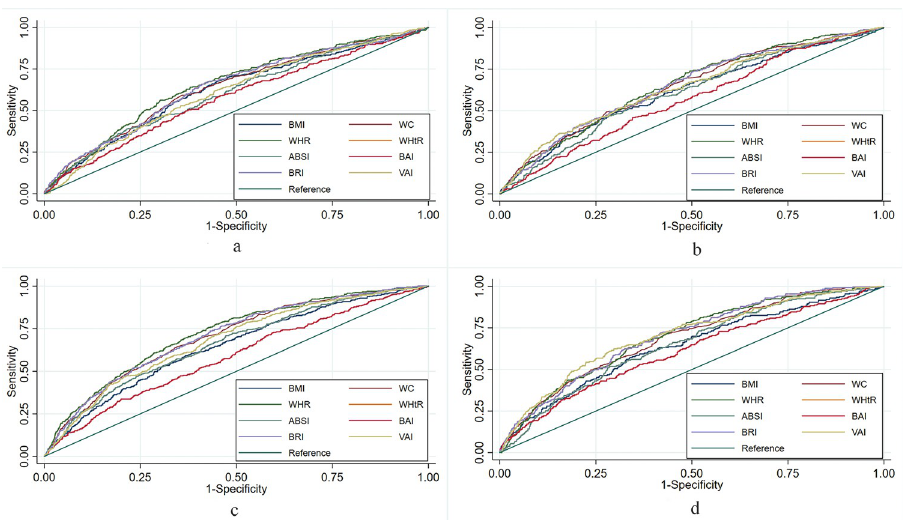
Fig 2. ROC (Receiver operator characteristic curves) for anthropometric indices to screen for diabetes in both sexes of the Dong and Miao ethnic groups. a is for the men of the Dong ethnic group, b is for the men of the Miao ethnic group, c is for the women of the Dong ethnic group, and d is for the women of the Miao ethnic group.